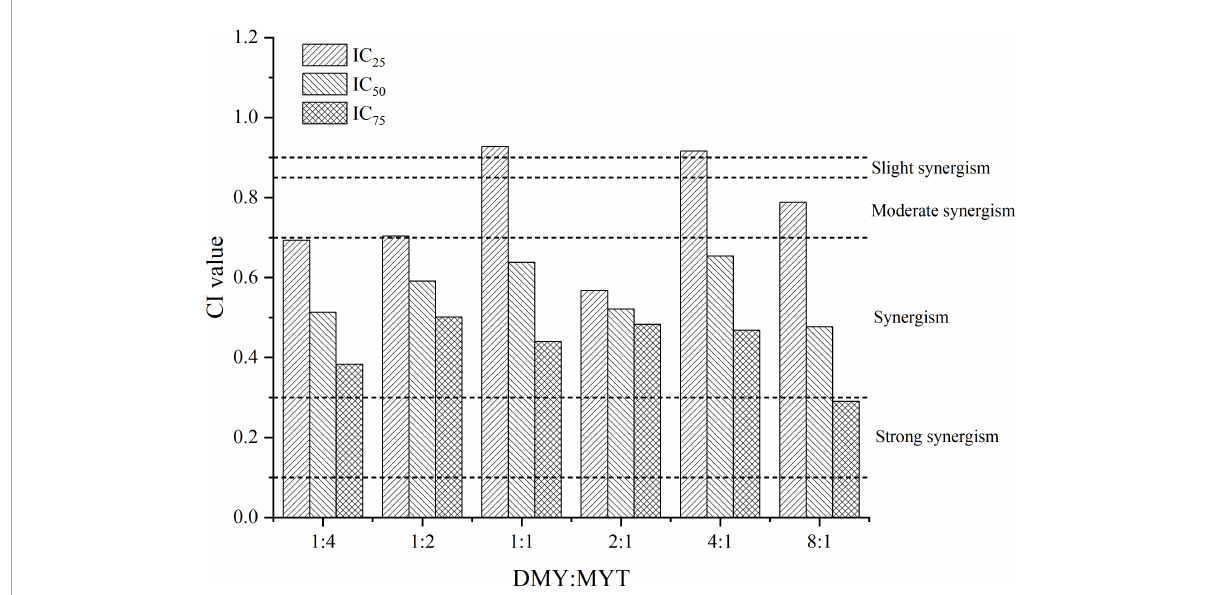
FIGURE7 Analysis of the combined effect of DMY and MYT on inhibiting tyrosinase in B16F10 cells. Values are means ± SD ( n = 3). After B16F10 cells were treated with DMY, MYT, or mix-use (1:4 ∼ 8:1) for 72 h, 90 µ L of 1% TritonX-100 was added to each well, and then 10 µ L of 1.0 mg/mL L-DOPA was added. The absorbance at 490 nm was measured after 5 min of ultrasound and treatment at 30 ◦ C for 30 min. The dose-response relationship was obtained by transformation according to the equation. The CI value was calculated by the equation. DMY, dihydromyricetin; MYT,